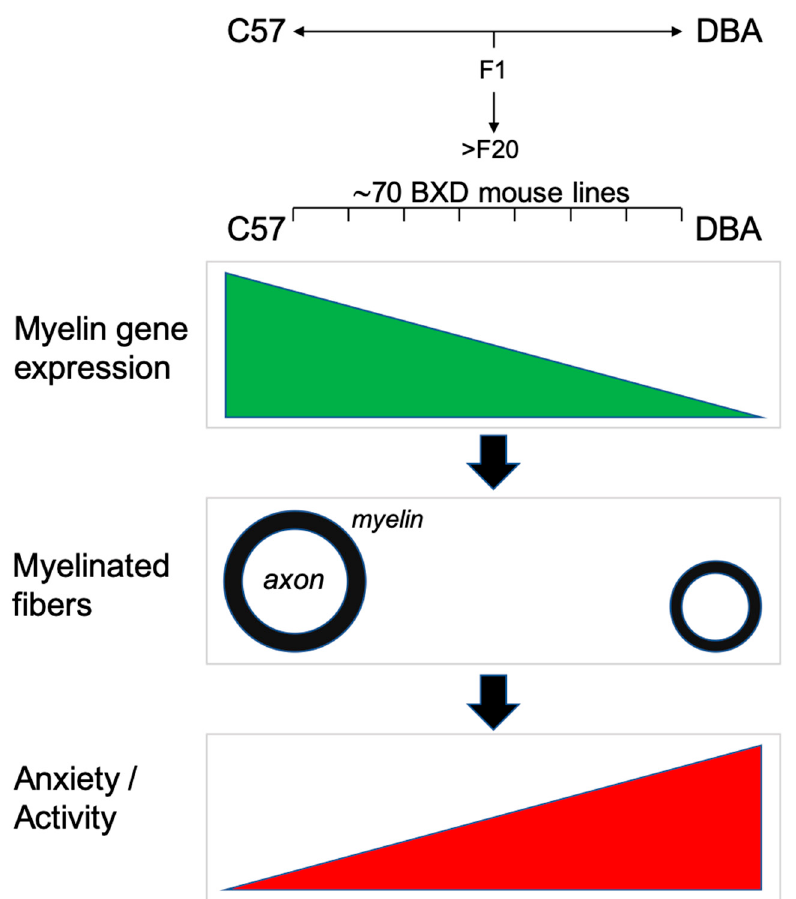
Figure 8. A summarizing view on the correlation of myelin gene expression, myelin fiber diameter and behavioral traits involving anxiety and/or activity.